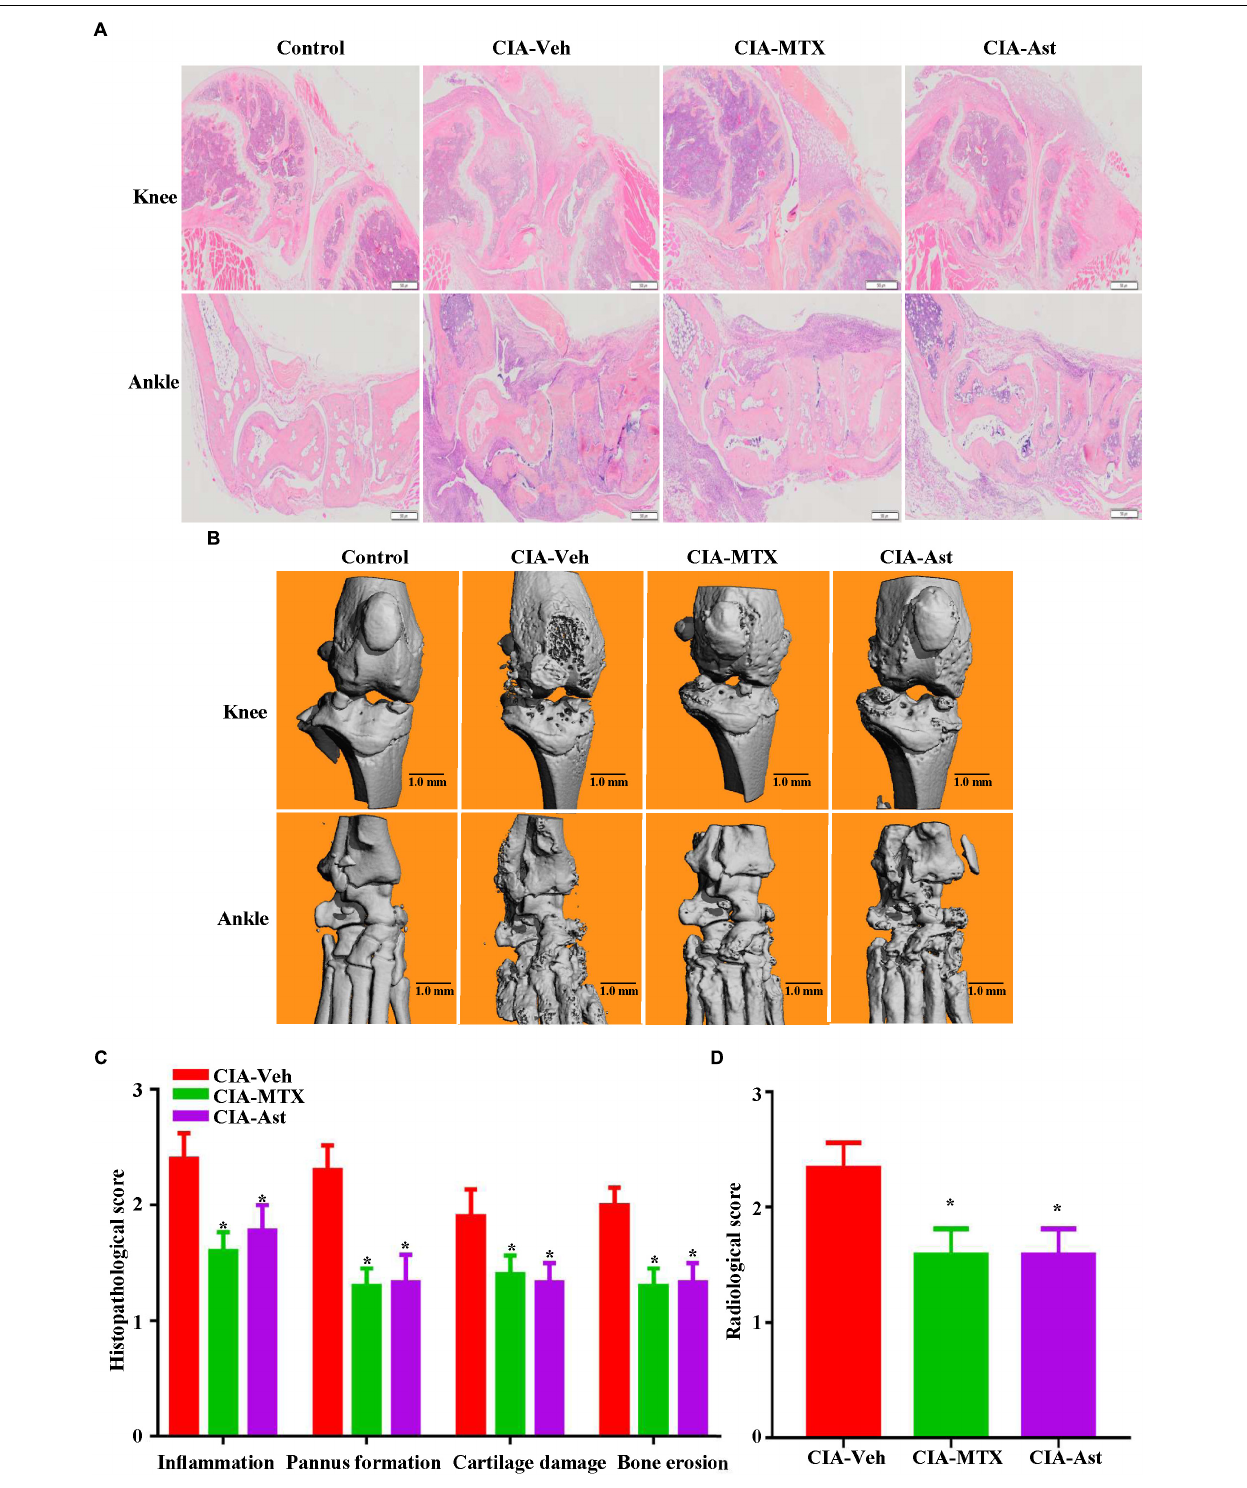
FIGURE 3 | Astragalin alleviated synovial inflammation and joint destruction. On day 50, mice were sacrificed, the knee and ankle joints stained with hematoxylin and eosin (A) . 3D reconstructions of the micro-CT analysis from CIA mice using the SCANCO proprietary software (B) . The histopathological severity was assessed and calculated (C) . Bone radiological destruction scores were attributed from the micro-CT analysis (D) . Data are shown as mean ± SEM of ten mice per group, ∗ p < 0.05 versus CIA-Veh group.